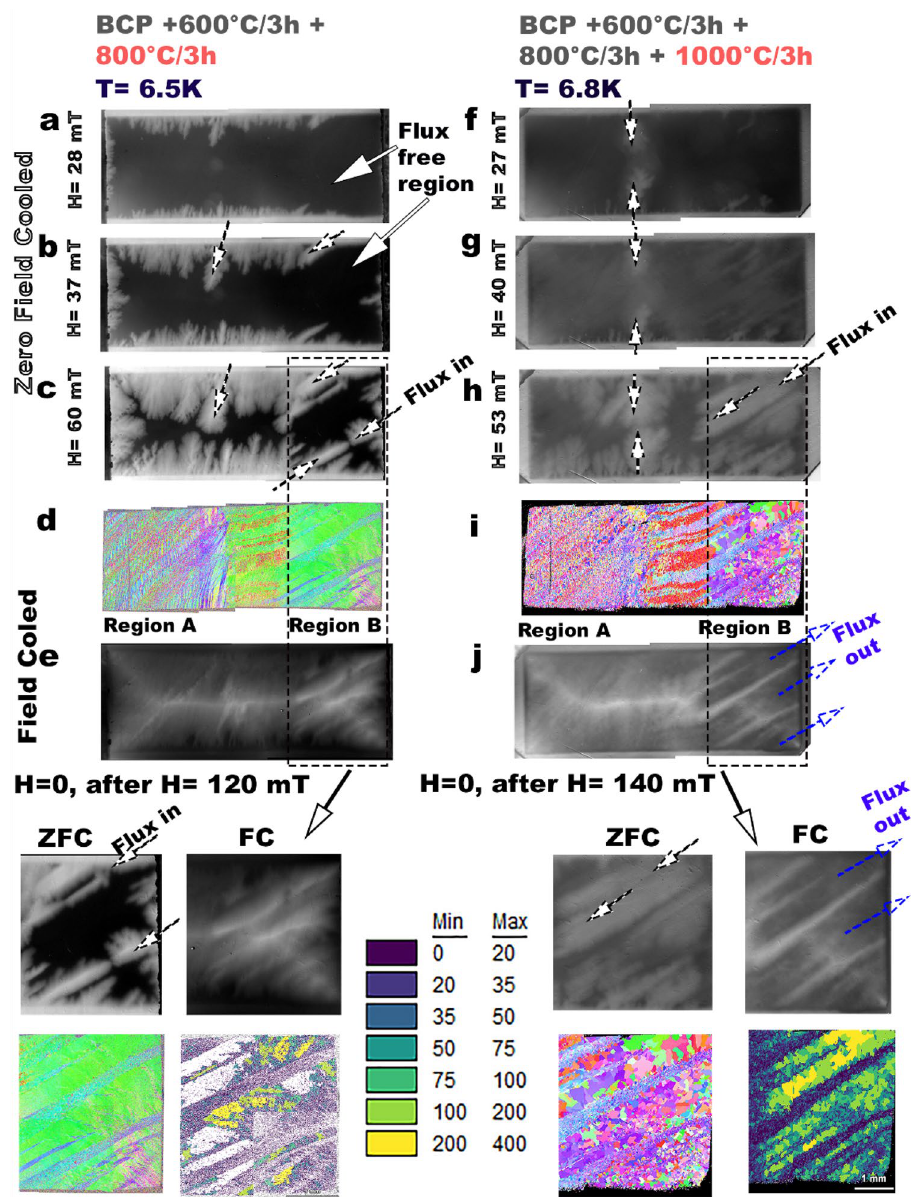
Figure 4. MOI images showing the flux flow characteristics in Nb after different heat treatments that show significant microstructure variations, ( a – c ), and ( f – h ) indicate flux flows into Nb at T (6.5–6.8 K) < T c (9.2 K) of Nb with increasing magnetic fields starting from an initial fully superconducting state, based on zero-field cooled (ZFC) mode. ( d , i ) represent the full cross-section microstructure as a reference from EBSD-OIM, and ( e , j ) trapped flux images based on field cooled (FC) mode, indicating flux exit or expulsion from select regions of large grain (LG: 100–400 µm) microstructure, and flux trapping along fine grain (FG: < 100 µm) regions. The dark regions in the MOI images represent flux free regions. In an ideal superconductor, external magnetic fluxes are completely expelled after removing the external field. The IPF’s were generated using the TSL OIM Analysis (Version 7.0), link: https ://www.edax.com/produ cts/ebsd/oim-analy